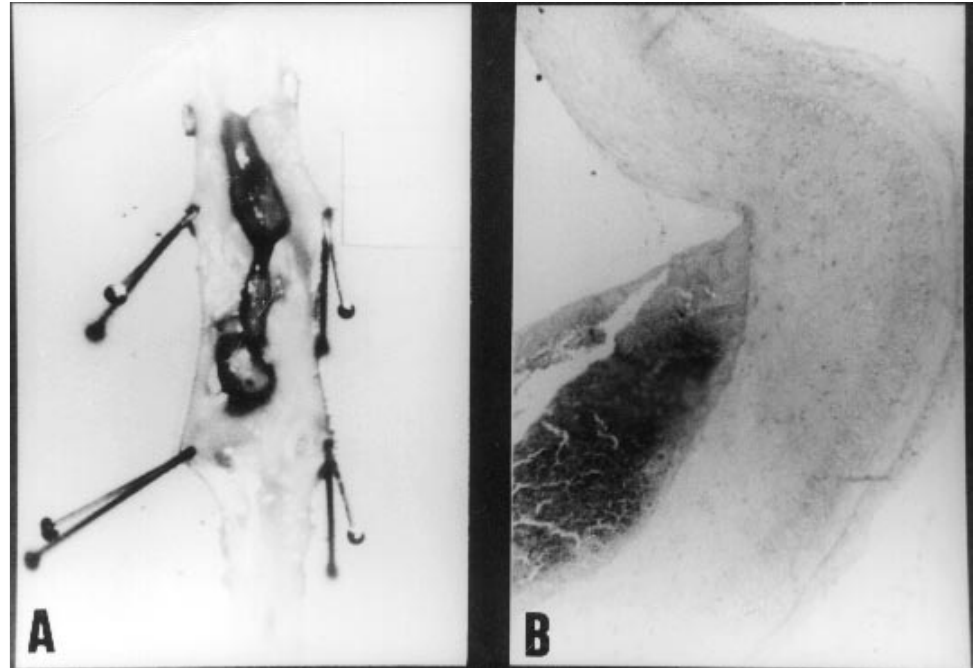
Figure 1 - A , Photograph of a representative aortic segment showing a white thrombus in the abdominal aorta. The aortic wall is thick and has lost its nor- mal transparency. There are also 2 thrombi connected by a red fibrin and platelet-rich (cid:147)bridge(cid:148). B , Histology specimen (H&E) showing injured artery and